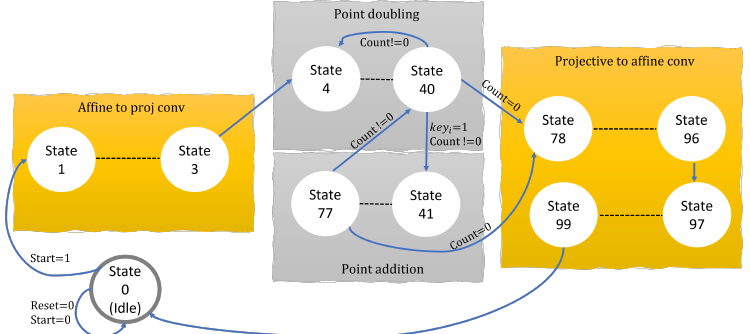
Figure 2. Dedicated control unit of proposed hardware